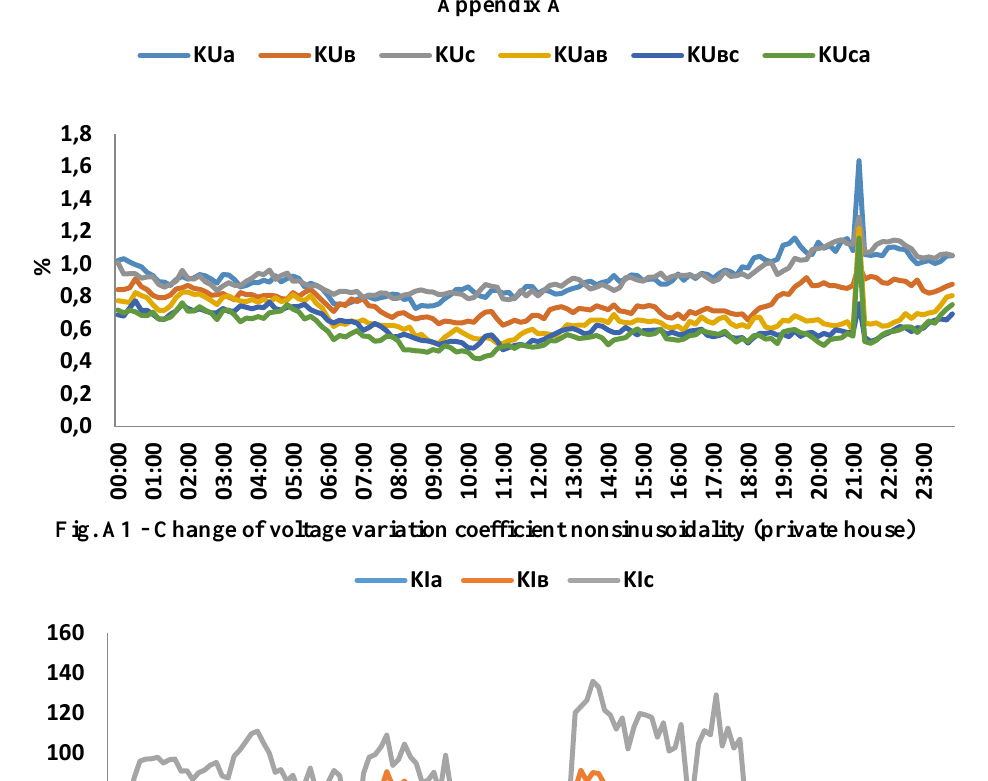
Fig. A2 - Change of current change coefficient nonsinusoidality (private house)